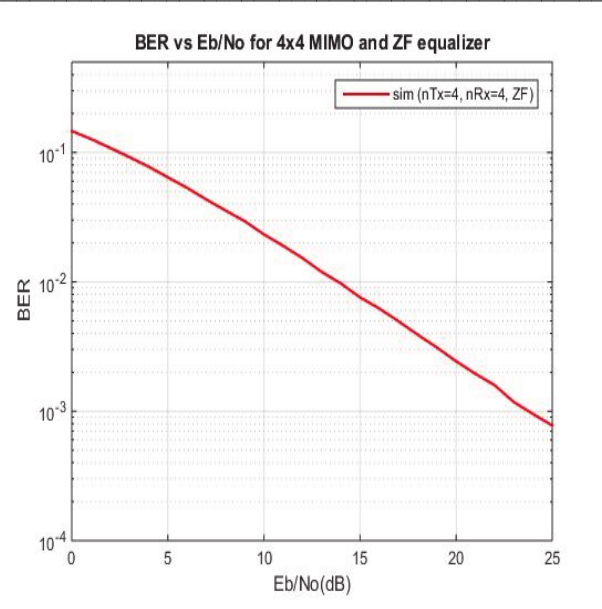
Fig. 1. Zero forcing BER vs E b / N o MMSE signal detection.